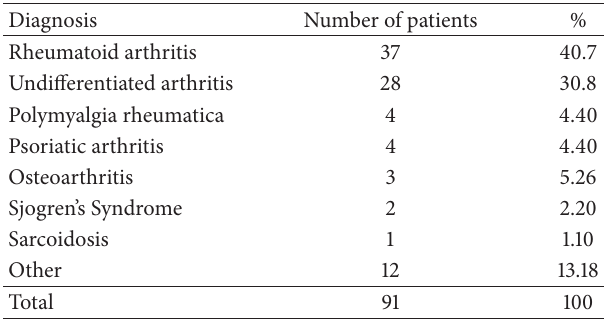
Table 3: Variables associated with devolvement of rheumatoid arthritis in univariable